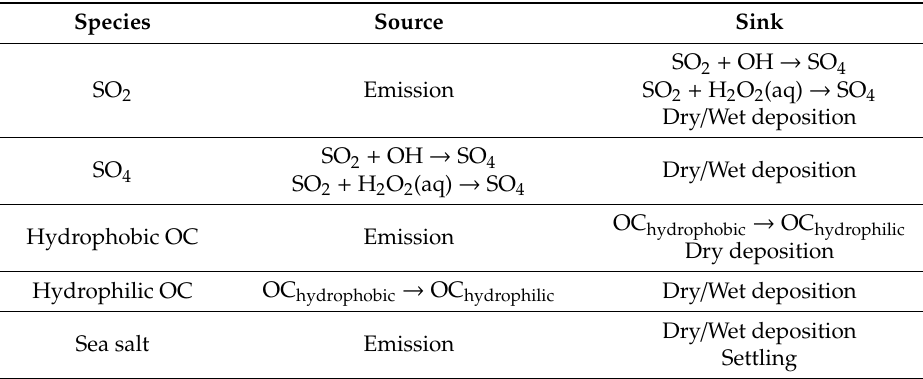
Table 1. Source and sink terms for the five species